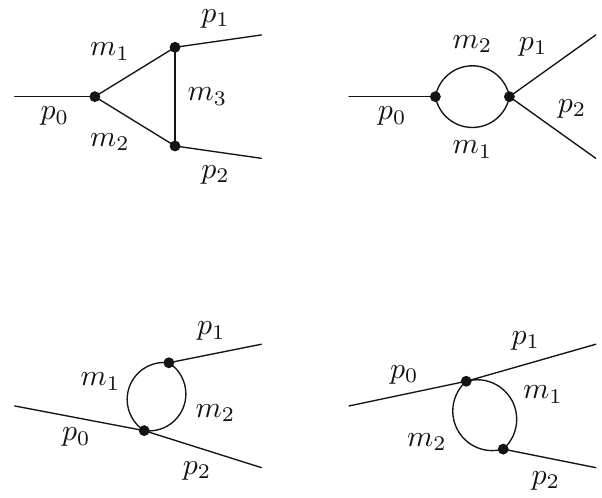
Fig. 1 Possible topologies contributing to the vertex corrections